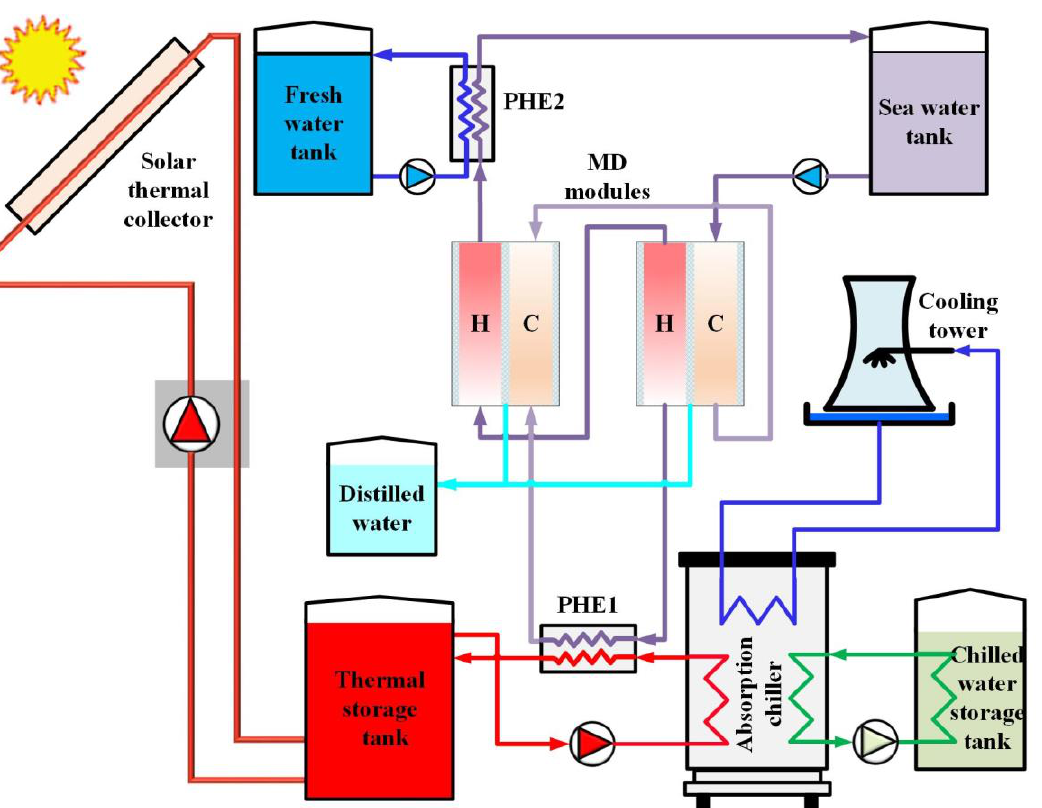
Figure 16. Schematic layout of solar MD-ABR system (adapted from [128]).